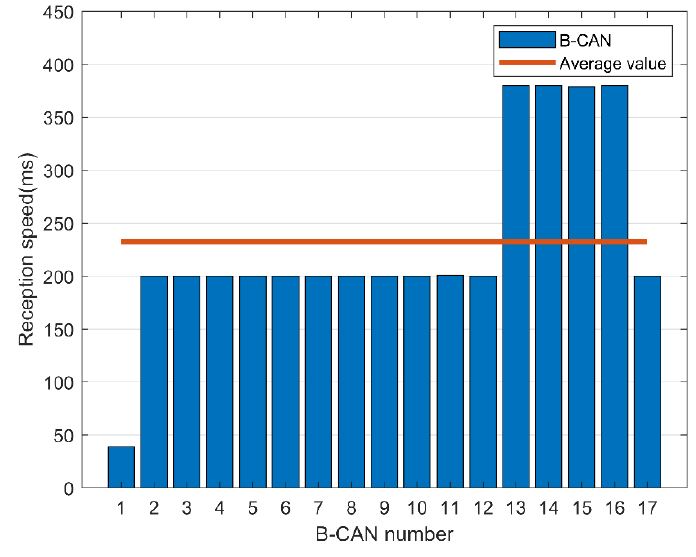
Figure 13. Message reception speed in B-controller area network (CAN).